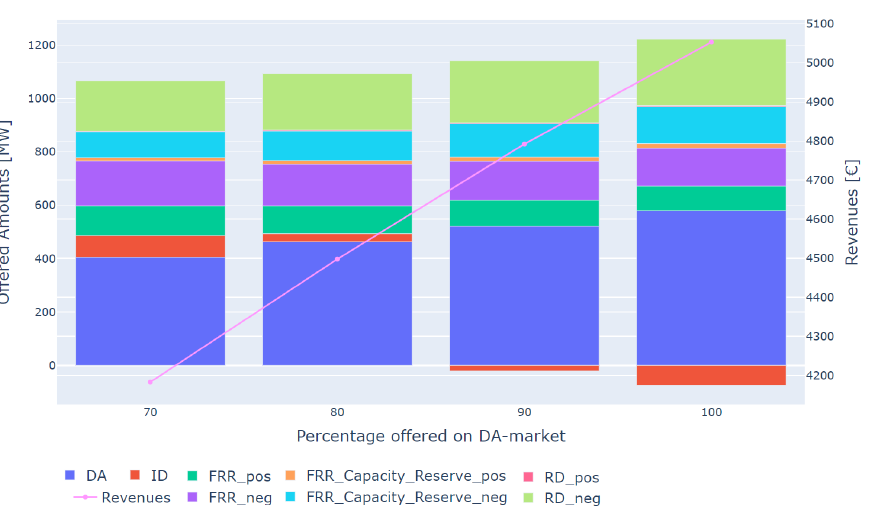
Figure 6. On the x -axis, there is the percentage of the forecast, which could be offered at the day- ahead market (including balancing capacity market); the rest has been traded at intraday markets (including balancing energy and redispatch market). The simulation data are for Zone West,